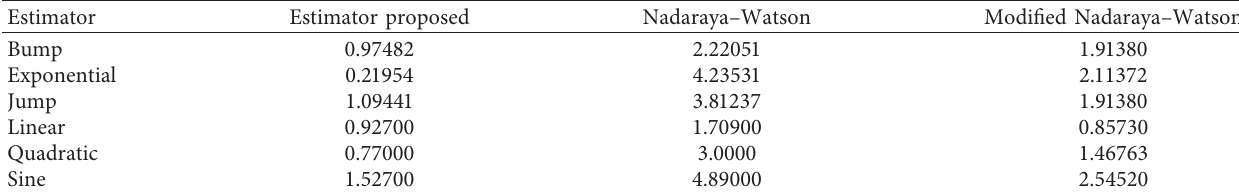
Table 4: Results of the confidence interval